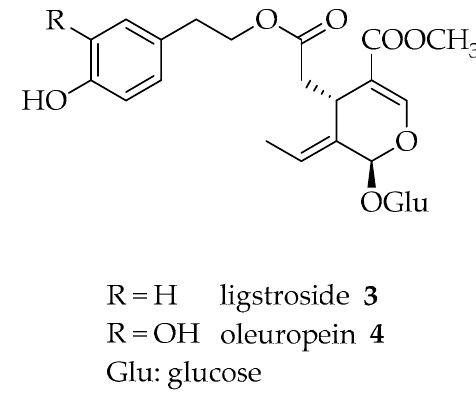
Figure 1. Chemical structures of phenols 1 – 4 .